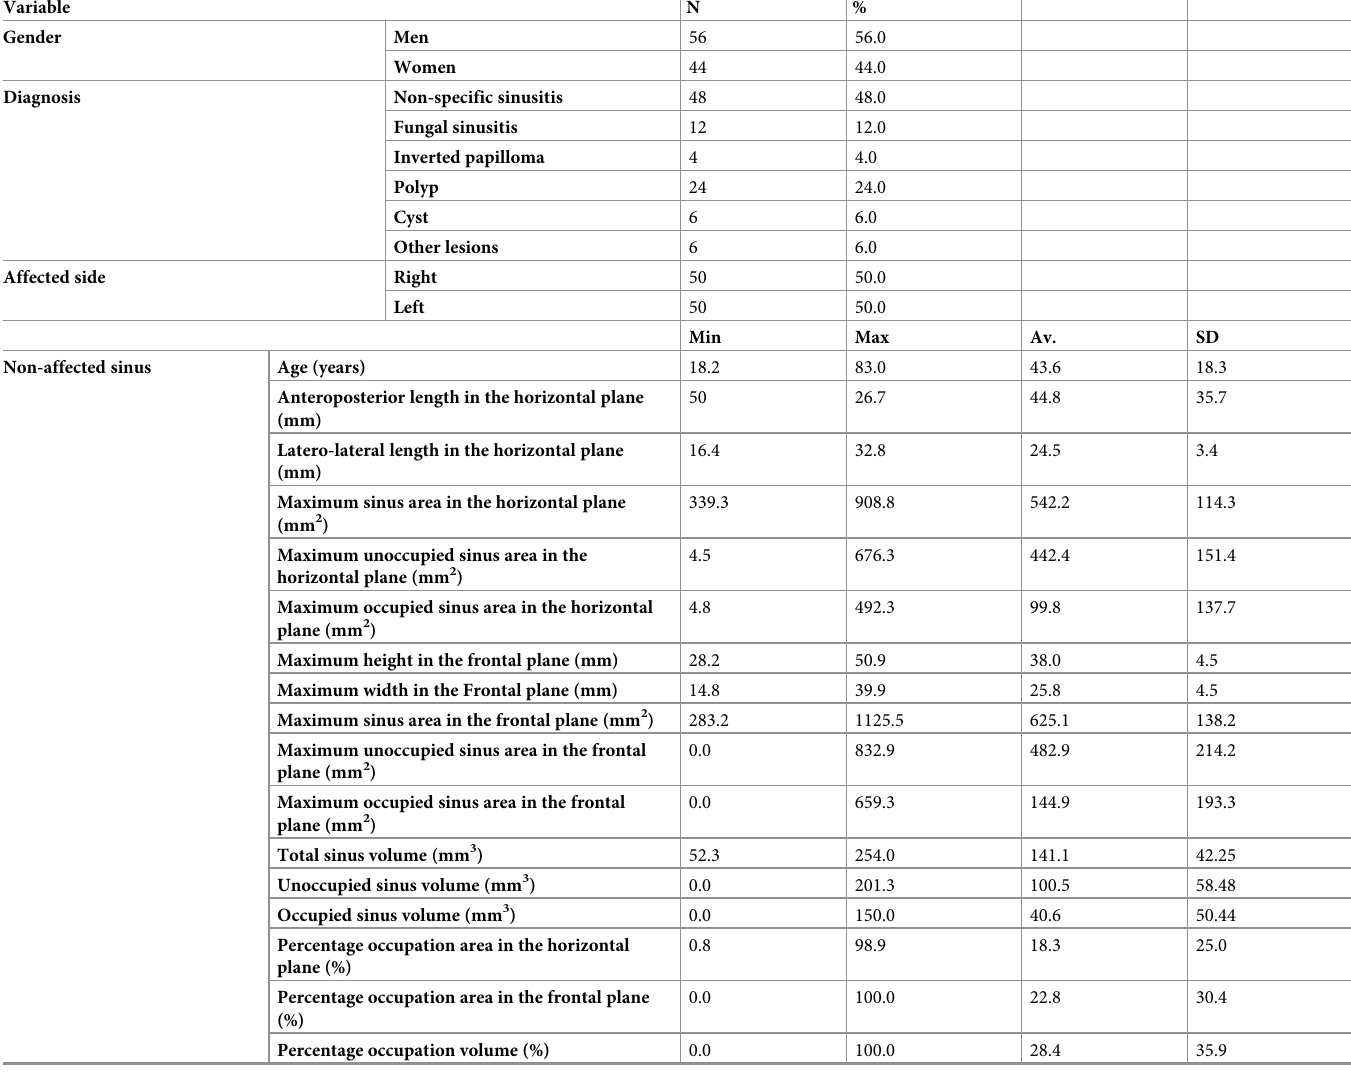
Table 1. Descriptive data. Descriptive data of all of the study variables classified according to sinus involvement.